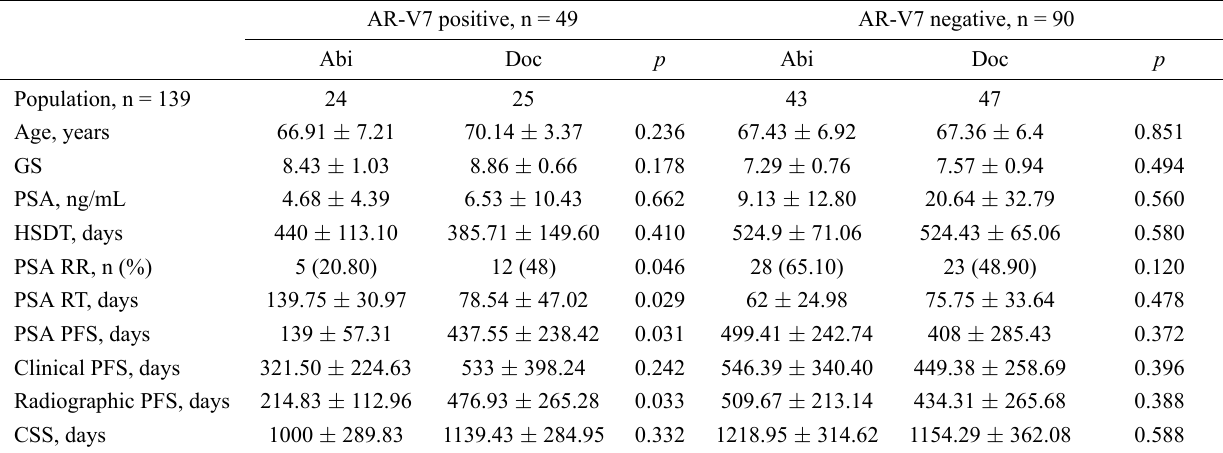
Table 3. Clinical characteristic and time-to-event outcomes of abiraterone- and docetaxel-treated patients with AR-V7-positive status or AR-V7-negative status.